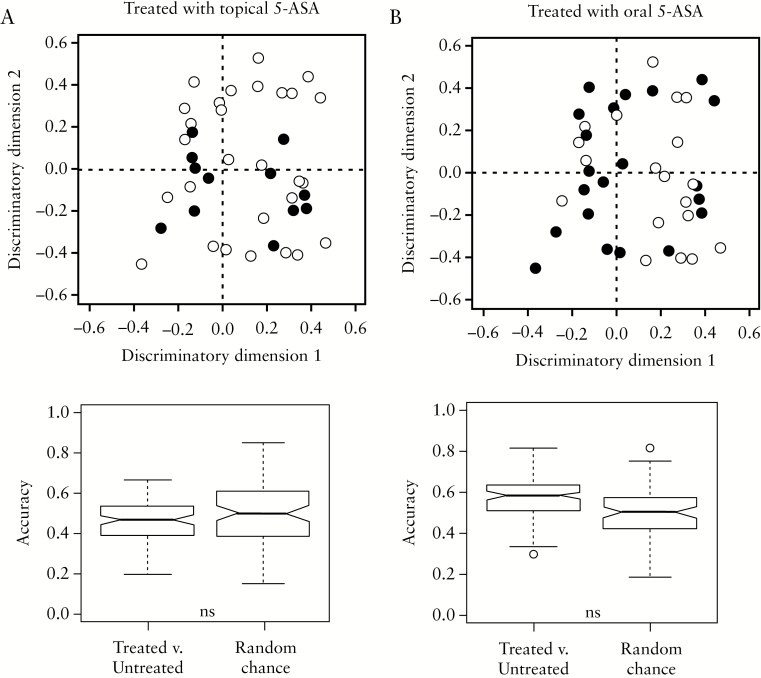
The plasma NMR metabolite profiles of patients treated with [A] oral 5-ASA and [B] oral 5-ASA [black] are evenly spread through the untreated samples [open circle] in the OPLS-DA scores plots.